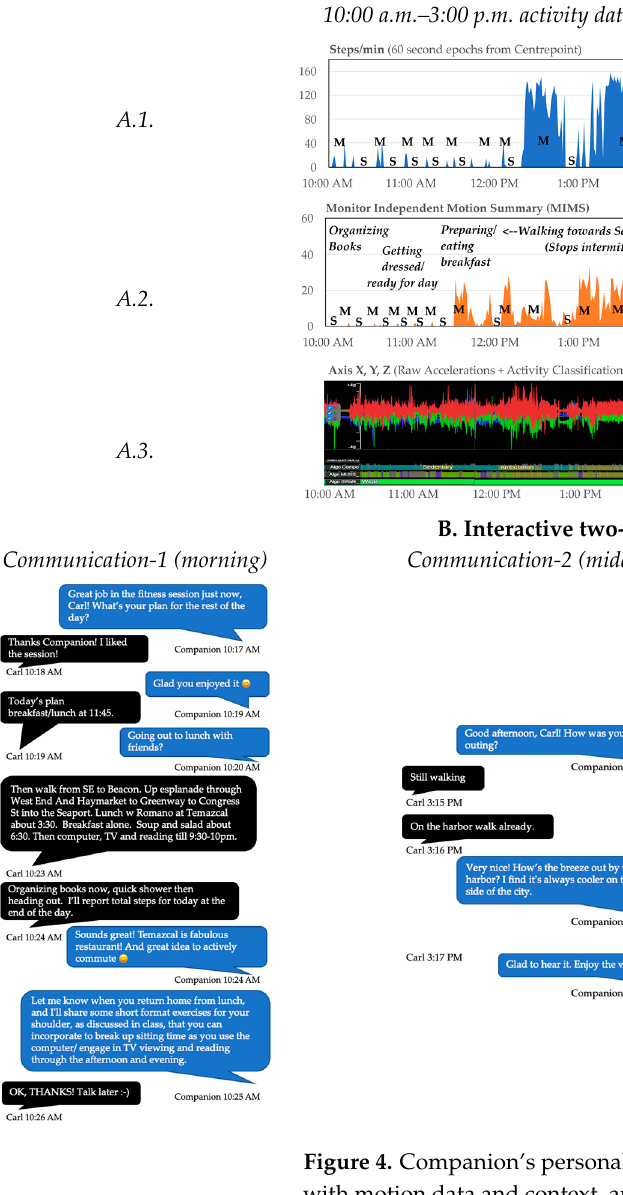
Figure 4. Companion’s personalized and interactive two-way communication, behavior mapping with motion data and context, and activity type classification. ( A ) Health coaches first detect major behaviors (i.e., movement [M] vs. sedentary [S]) by visualizing periods of whole-body locomotion (i.e., steps) on the ActiGraph Centrepoint platform ( A.1 .). This knowledge is used in conjunction with overall wrist motion summary data (MIMS) to further identify periods of non-locomotion movement ( A.2. ), e.g., MIMS helps health coaches identify if periods inferred as sedentary during